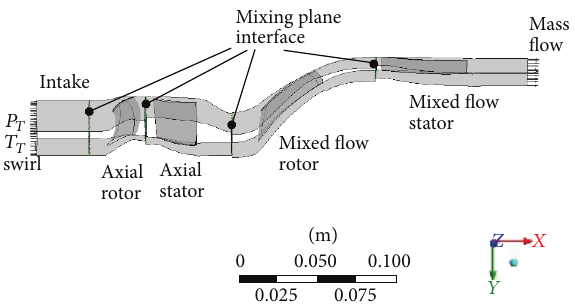
Figure 13: Computational domain for two-stage compressor.